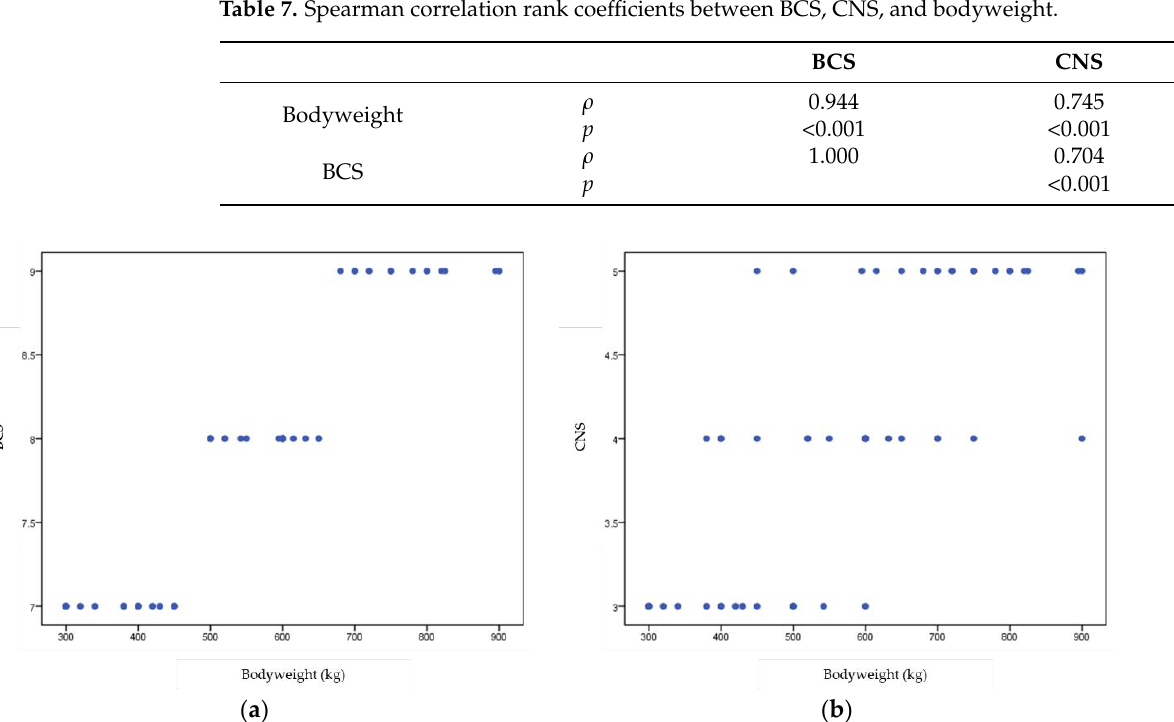
Figure 6. Correlation diagram of variables: bodyweight and BCS ( a ) and CNS ( b ).